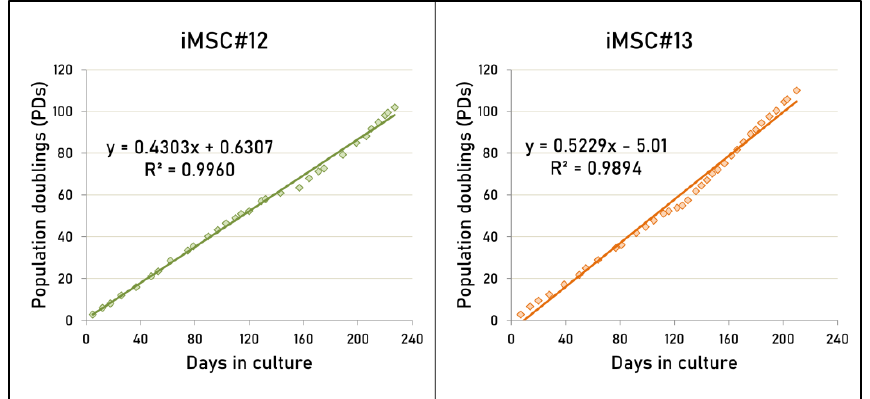
Figure 3. Number of population doublings (PDs) accumulated by both immortalized cell lines (iMSC#12 and #13) versus days in culture. PDs were calculated as (log Nf − log Ni )/log 2 (where Nf is the cell number at the end of a given subculture, Ni is the cell number used as inoculum to begin a given subculture, and log is the natural logarithm). Table 1. Phenotypical analysis to determine the mesenchymal and hematopoietic surface markers’ expression pattern in primary MSCs, T-MSCs and iMSCs at different (early and late) passages. Passage is represented as the number of subcultures as (1) primary MSCs, (2) T-MSCs and (3) iMSCs. Data from primary MSC#13 and T-MSC#13 could not be obtained because of limited cell number, and therefore only primary MSC#12 and T-MSC#12 are shown. Cells